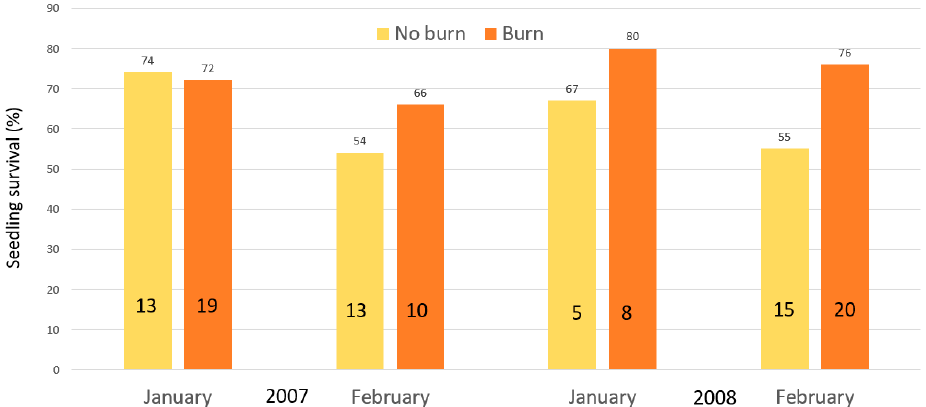
Figure 4. Prescribed burning (before planting in January or February) increased the survival of bareroot loblolly pine seedlings during a severe drought in central Alabama (data from Al Lyons; number on bar represents number of sites per mean). The increase in survival was significant except for January 2007. The least significant difference ( α = 0.05) for a one-tail test is − 11% and ± 14% for a two-tailed test.